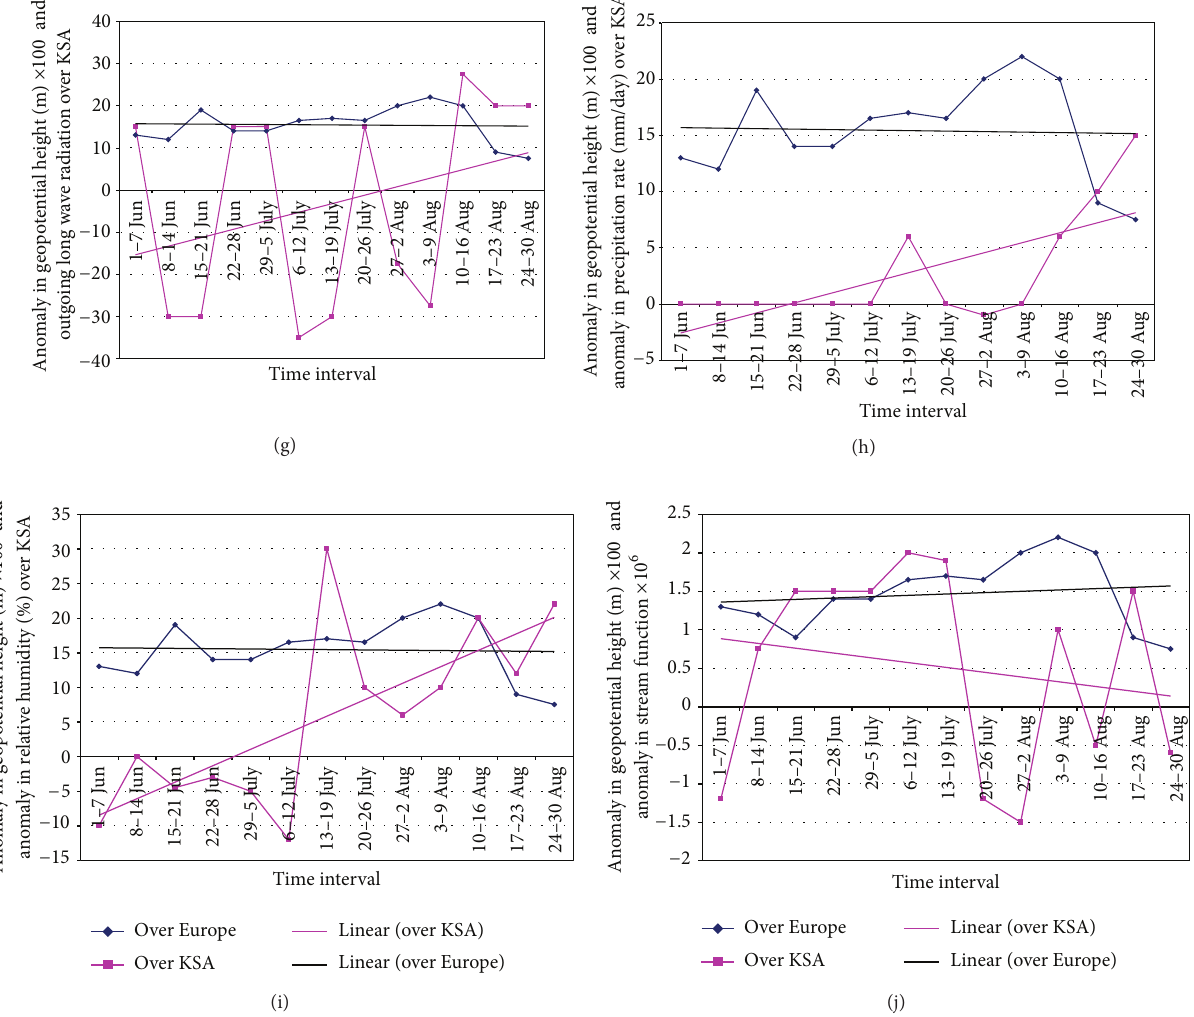
Figure 7: Time series analysis—7 days—of anomaly in geopotential height over Europe and anomaly of weather elements over KSA during the summer season